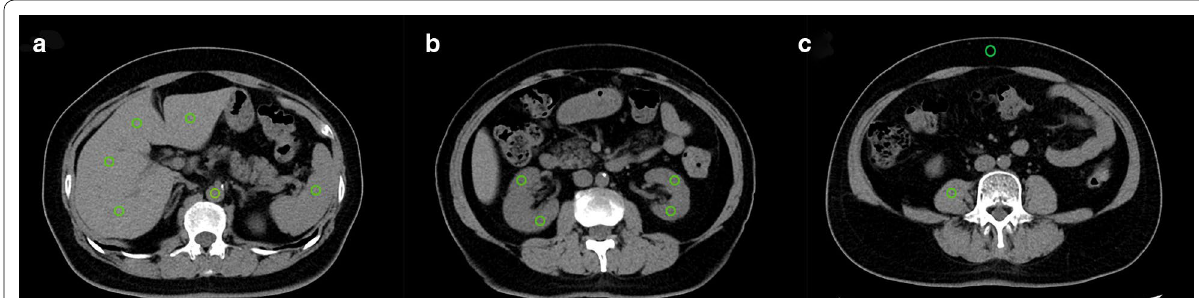
Fig. 1 ROIs were placed on the liver, spleen, aorta, kidneys, right psoas muscle, and abdominal-wall subcutaneous fat to measure CT values and noise of various abdominal organs and to evaluate the objective image quality. a shows ROIs located in the liver, spleen, and aorta. b shows ROIs located in the kidneys. c shows ROIs located in the right psoas muscle and anterior abdominal-wall subcutaneous